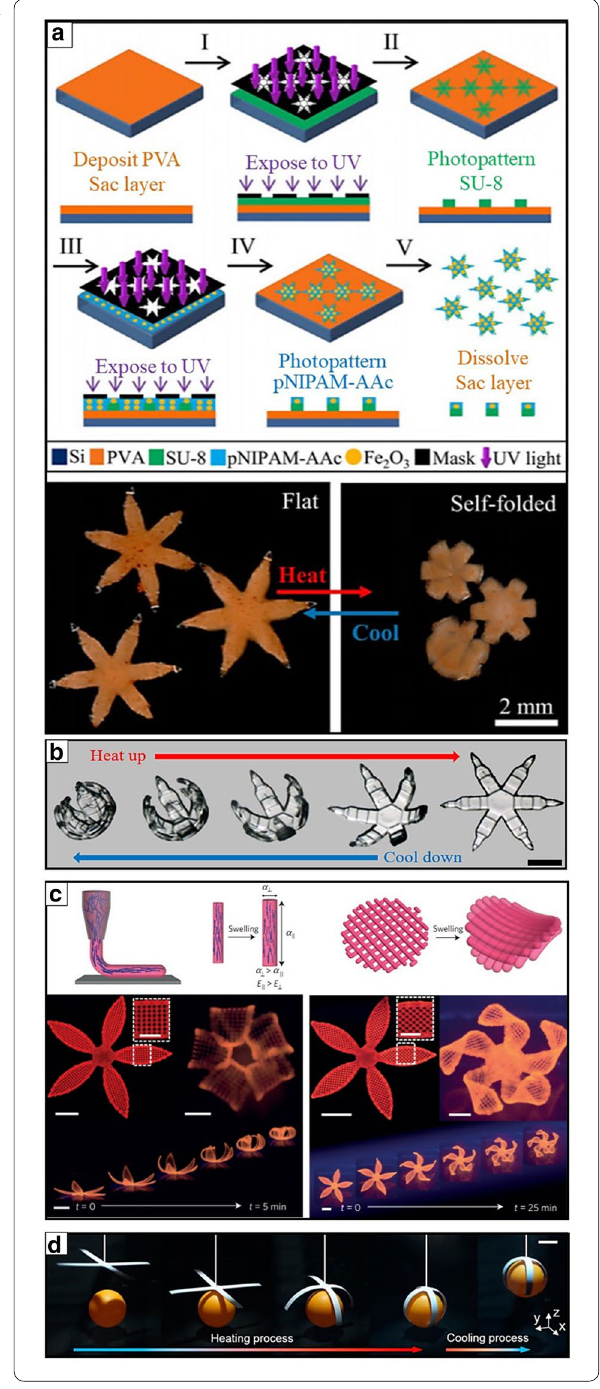
Fig. 4 Two main photolithographic and 3D printing methods to fabricate stimuli responsive soft grippers. a Process flow of photolithography to create stimuli responsive soft grippers with following two-step UV exposures. The photopatterned bilayer